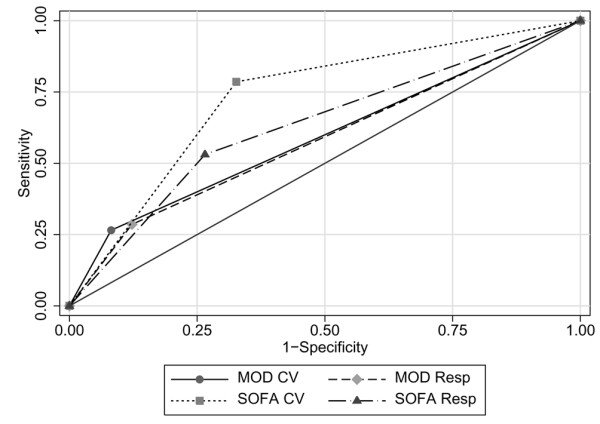
Area under the ROC curve for unfavorable urologic outcome by SOFA and MOD score organ system failure. MOD Multiple Organ Dysfunction; ROC, receiver operating characteristic; SOFA, Sequential Organ Failure Assessment.